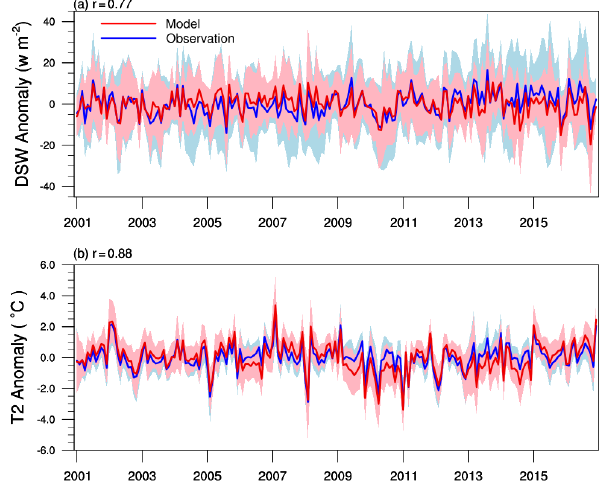
Figure 2. The comparison of monthly anomaly of downward short- wave (DSW) radiation (a) and 2m temperature ( T 2) (b) for model simulation and in situ observation, and the filled areas present the standard deviations among 98 sites for DSW and 697 sites for T